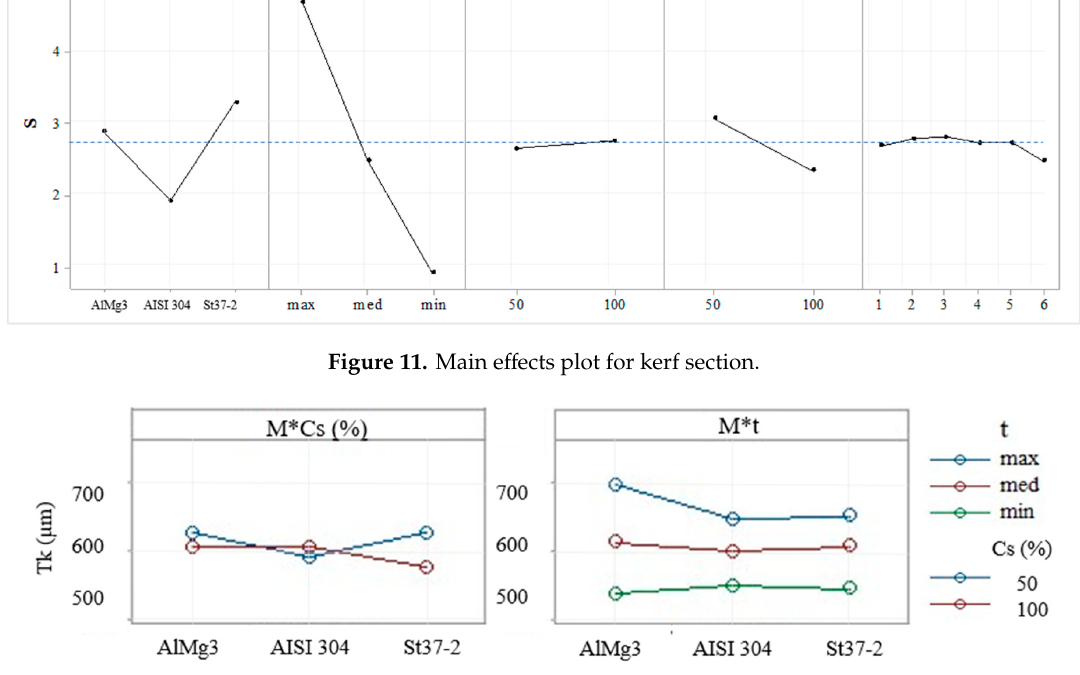
Figure 12. Interaction plot for top kerf width.